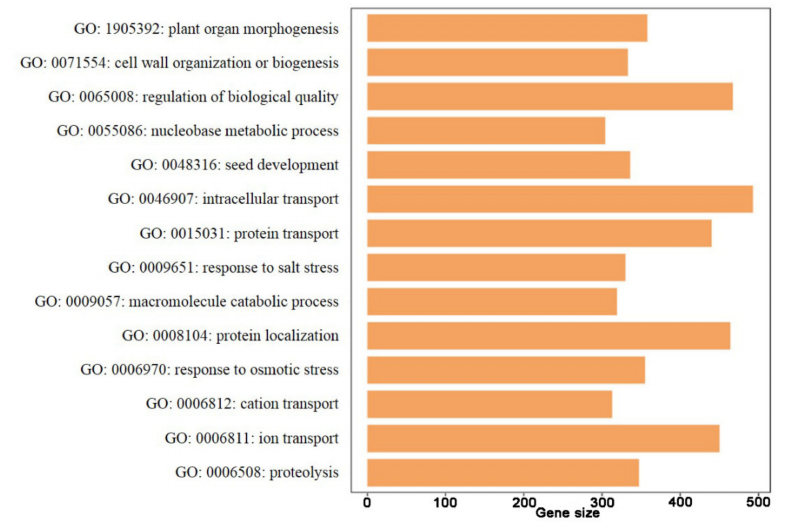
Figure 7. Gene set enrichment analysis (GSEA) enrichment analysis was performed base on GO